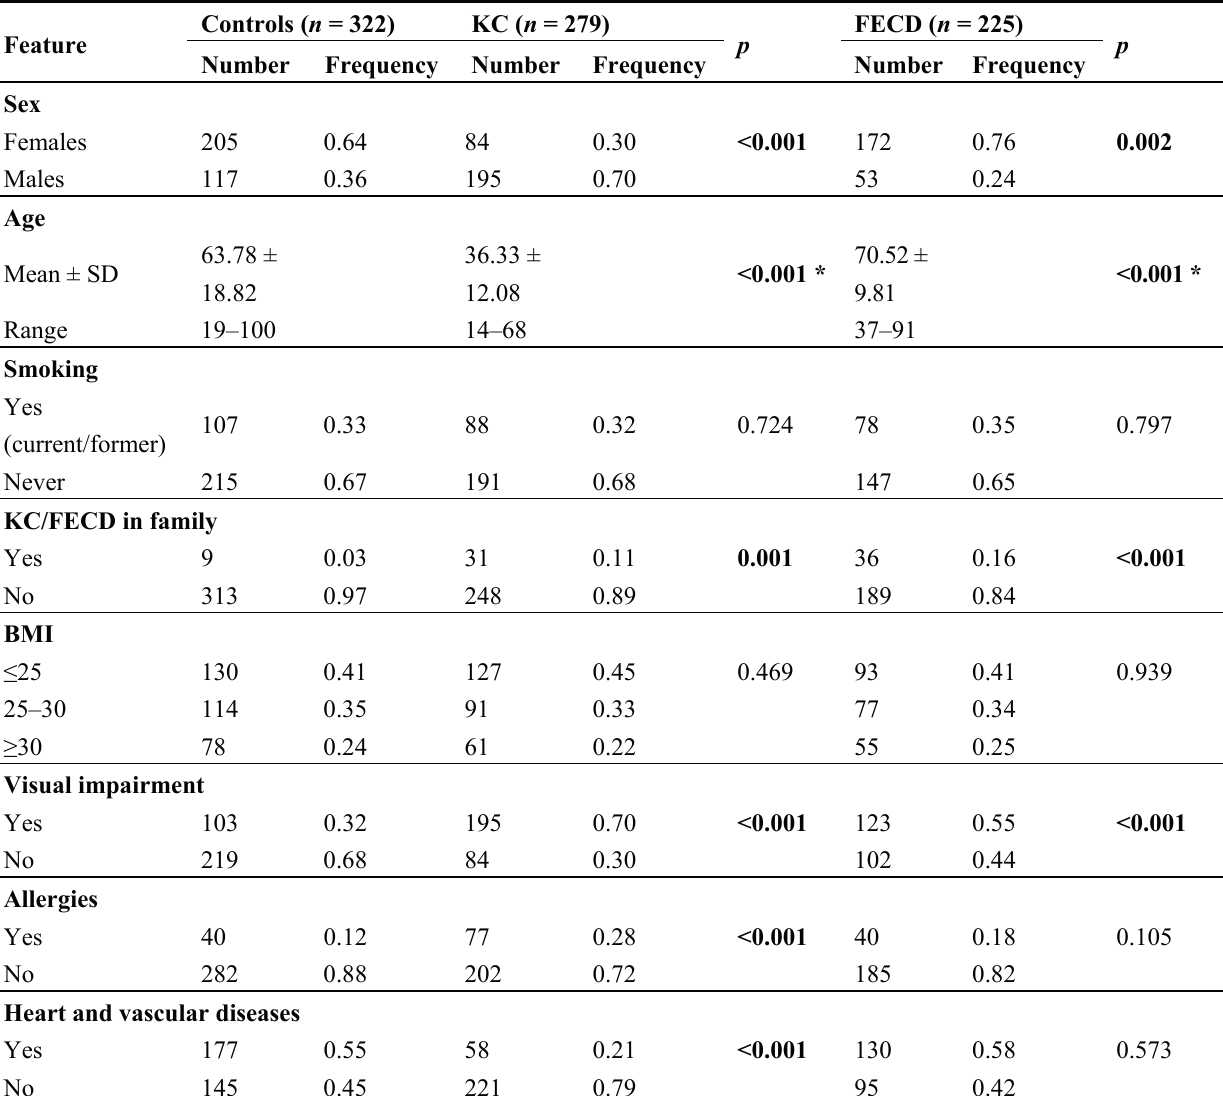
Table 1. Characteristics of keratoconus (KC) and Fuchs endothelial corneal dystrophy (FECD) patients and controls enrolled in this study